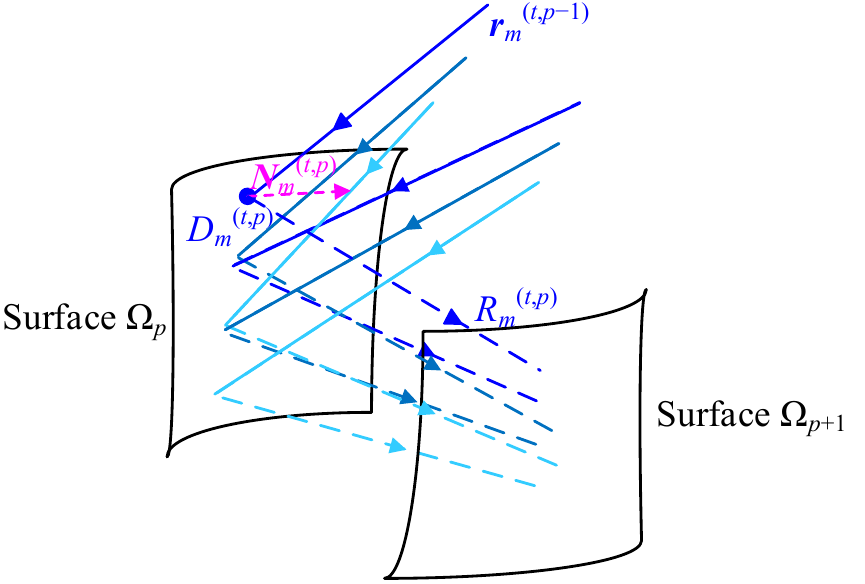
Figure 2. Calculation process for the data points during the iterative process.